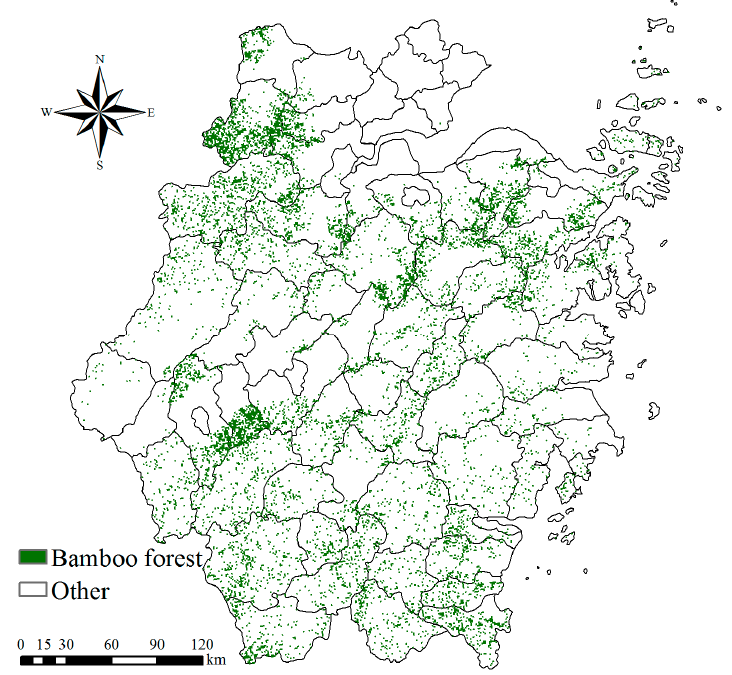
Figure 3. The bamboo forest distribution map of Zhejiang Province.